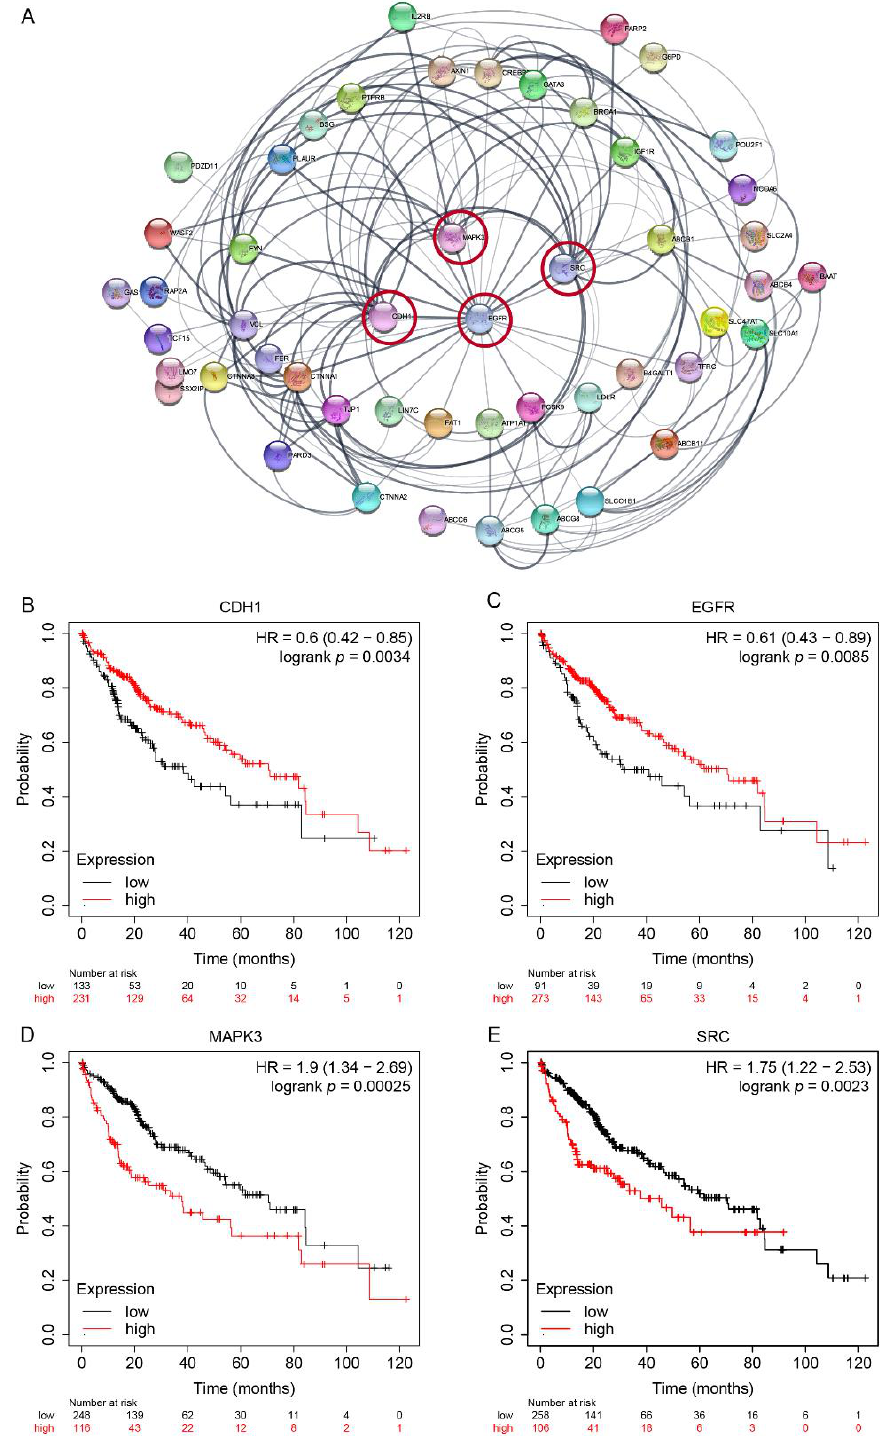
Figure 5. Network and survival curve of polarity-related genes with clinical value. ( A ) Protein – protein interaction (PPI) network of prognostic polarity-related genes. Thickness of connection denotes strongness of interaction evidence. The nodes with highest degree of connectivity were circled. ( B – E ) Survival curves of selected top four genes emerged from PPI network.